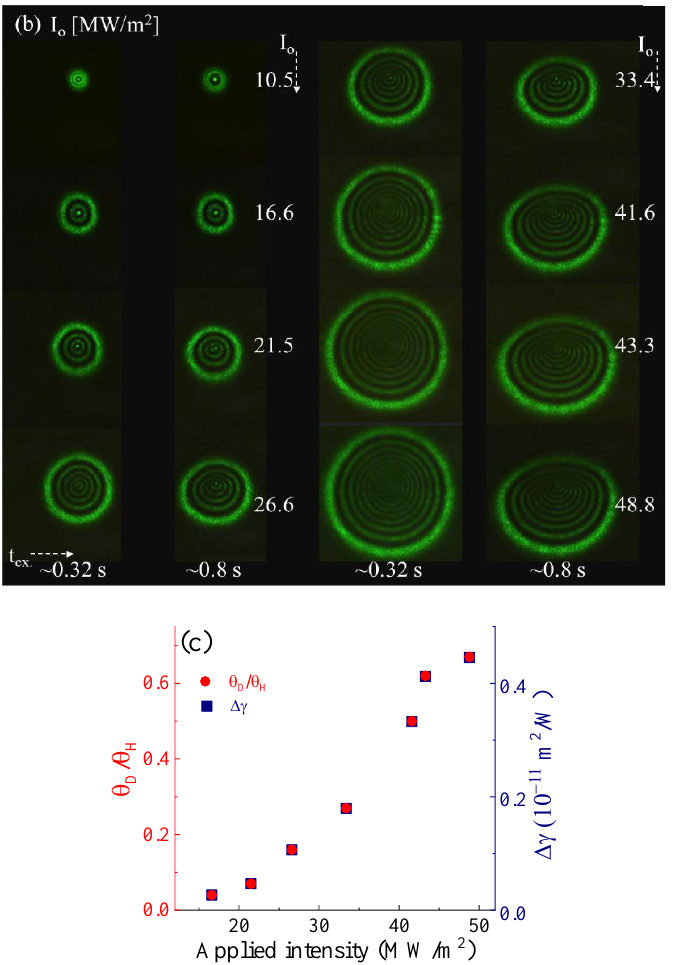
Figure 5. ( a ) Schematic sketch for the half-cone and distortion angles of SSPM, ( b ) SSPM diffraction images for different applied peak intensities at the excitation times of ~0.32 s and ~0.8 s, and ( c ) the ratio of θ D / θ H ( left y-axis) and the change of nonlinear refraction coefficient ( right y-axis) as a function of applied peak intensity.